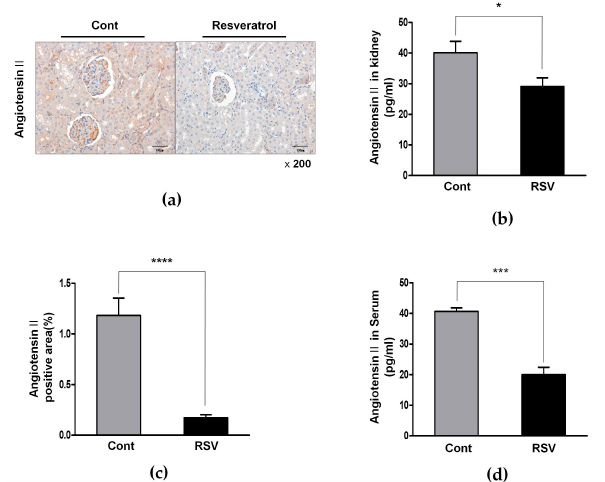
Figure 5. Effects of resveratrol on the Ang II. ( a ) Representative images of immunohistochemical staining with Ang II in aging kidney glomerulus (original magnification 200×). ( b ) The expression of Ang II in kidney was significantly decreased in the RSV group. ( c ) Ang II-positive area in kidney were observed to be significantly smaller in the RSV group; ( d ) The expression of Ang II in serum was also significantly decreased in the RSV group (* p < 0.05, *** p < 0.001, **** p < 0.0001). Furthermore, the expression of AT1R was decreased significantly (control 1.00 ± 0.06 vs. resveratrol 0.76 ± 0.05-fold, Figure 6a,b), as well as AT1R-positive areas, by immunohistochemistry (control 7.02 ± 2.88 vs. resveratrol 0.84 ± 1.19%, Figure